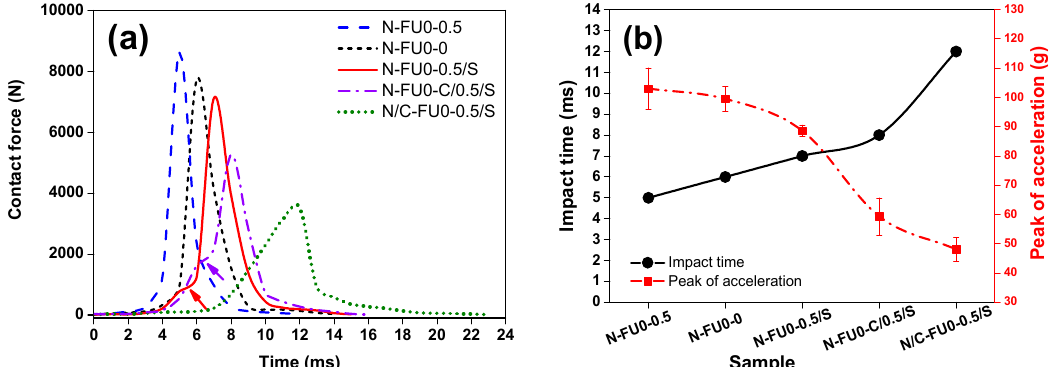
Figure 9. Impact signals at 10 J of MFRCs ( a ) contact force-time curve of MFRCs and ( b ) impact time and peak acceleration of MFRCs.